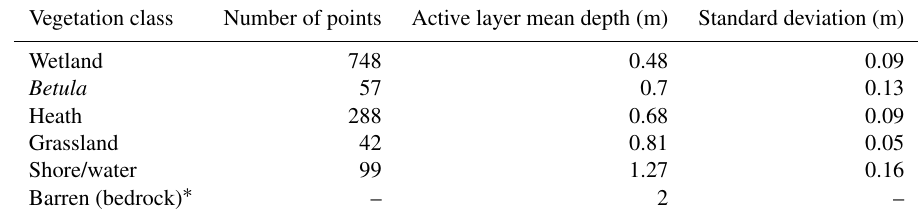
Table 3. Summary of GPR points from Fig. 3a and wave velocities from Table 2.